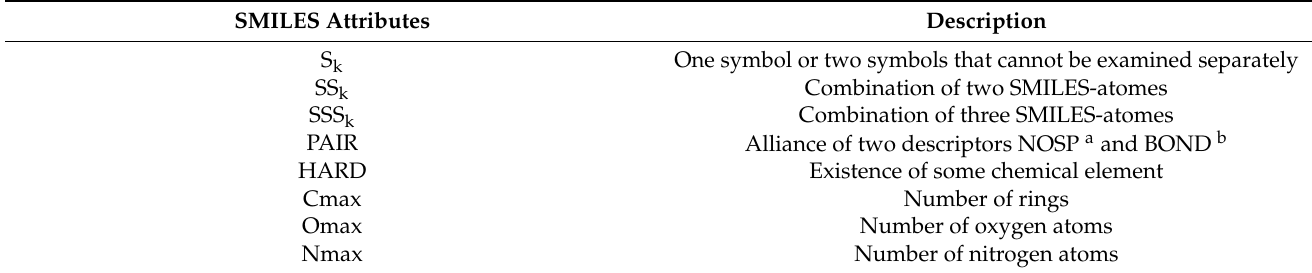
Table 10. The detailed description of SMILES